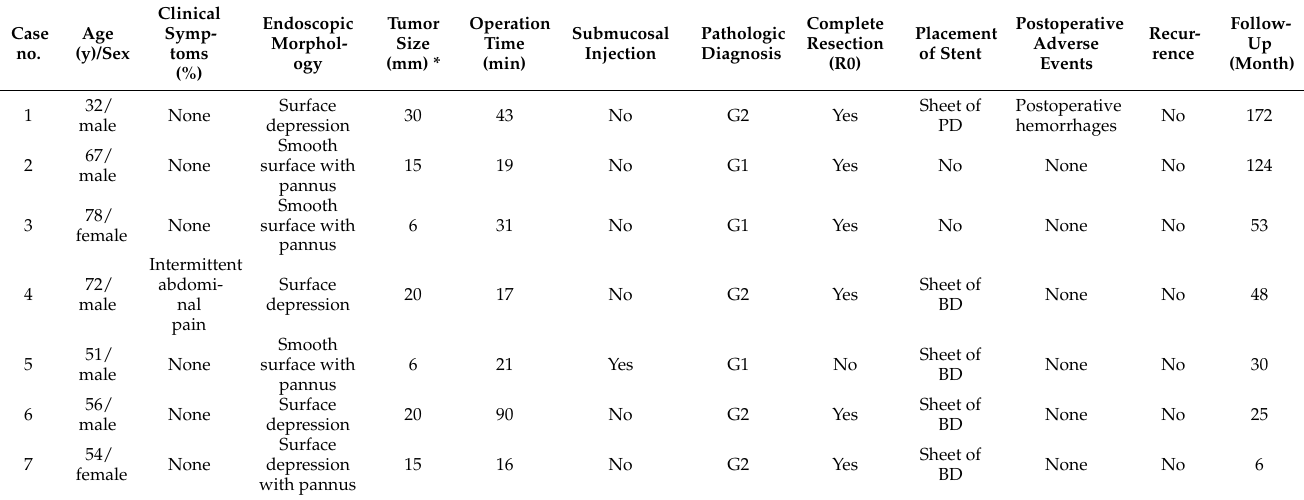
Table 1. Clinical characteristics and outcomes for seven patients with ampullary neuroendocrine tumors after endoscopic papillectomy (from our